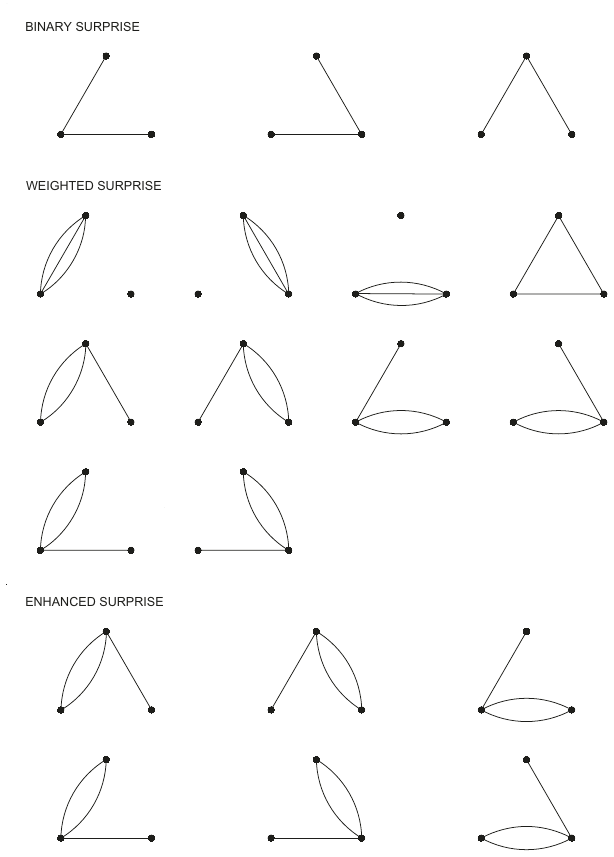
Fig. 1 Graphical comparison of different ways of counting